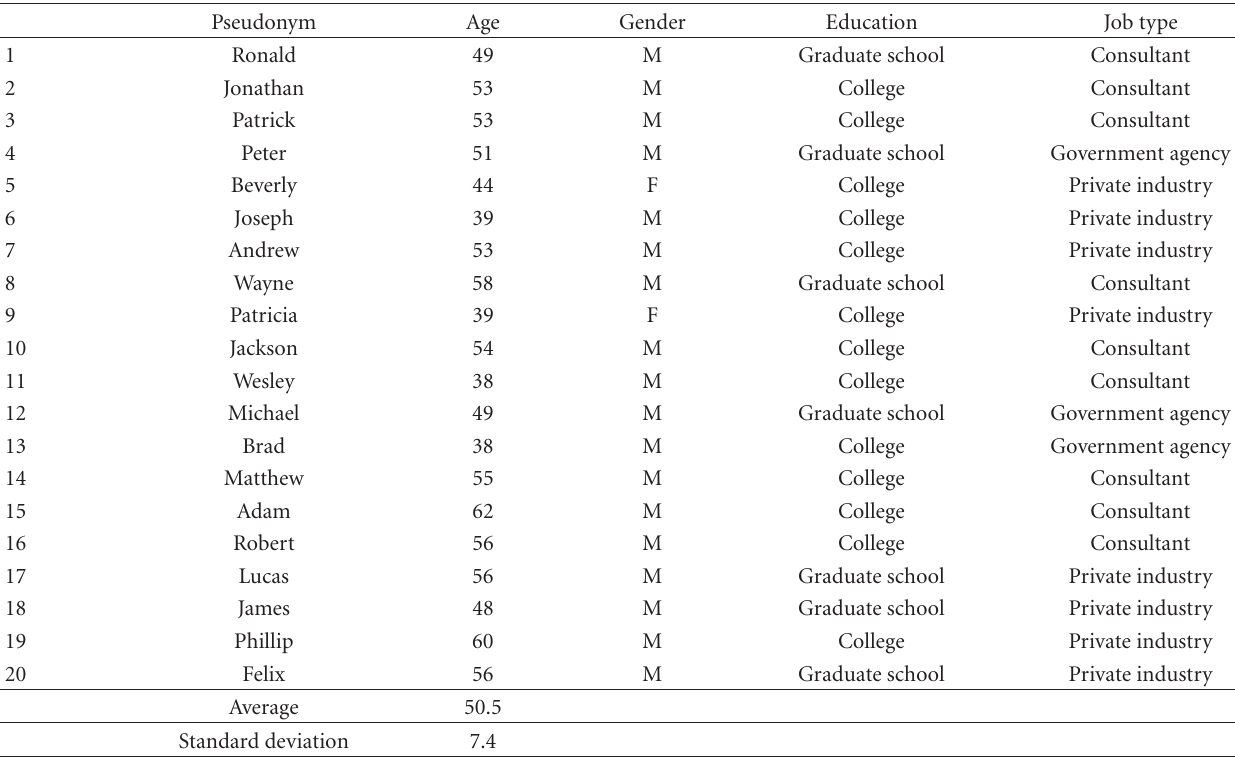
Table 2: Forest manager respondents.